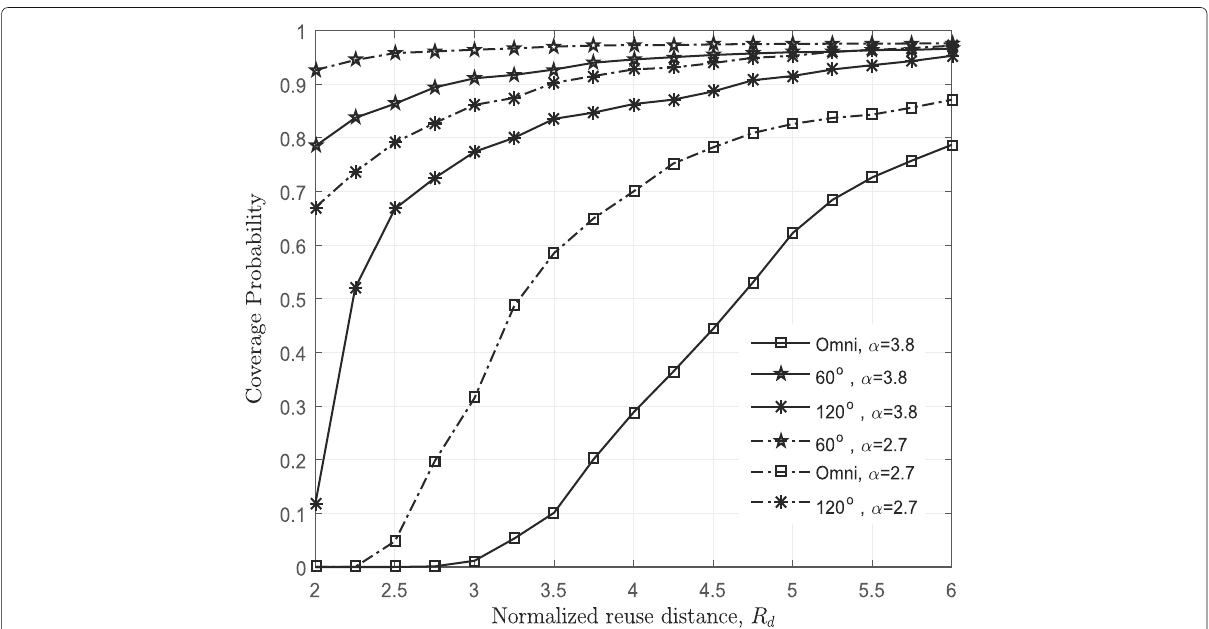
Fig. 14 Coverage probability of cellular network as a function of normalized reuse distance R d for omni, 120 ◦ and 60 ◦ antenna configurations with m = 3, path loss exponent α = 3.8 and 2.7. Coverage probability for omni antenna with α = 3.8 and 2.7. Coverage probability 120 ◦ sectorized antenna with α = 3.8 and 2.7. Coverage probability 60 ◦ sectorized antenna with α = 3.8 and 2.7